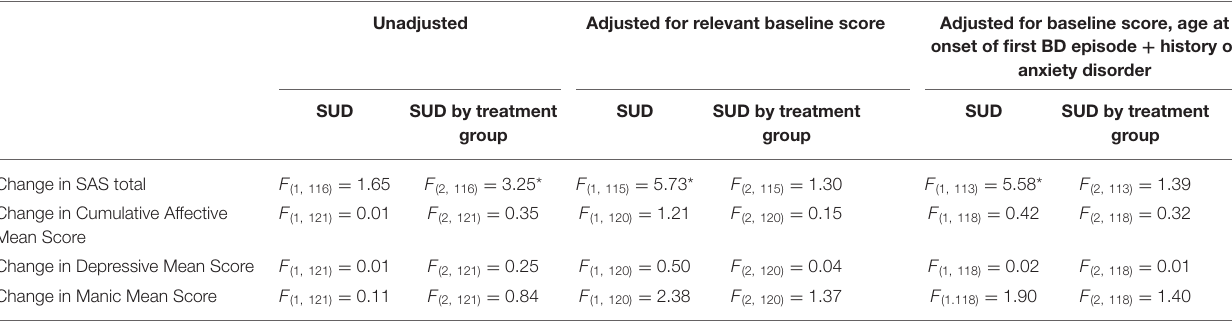
TABLE 4 | Primary analyses—estimated marginal means and confidence intervals for change in SAS total.